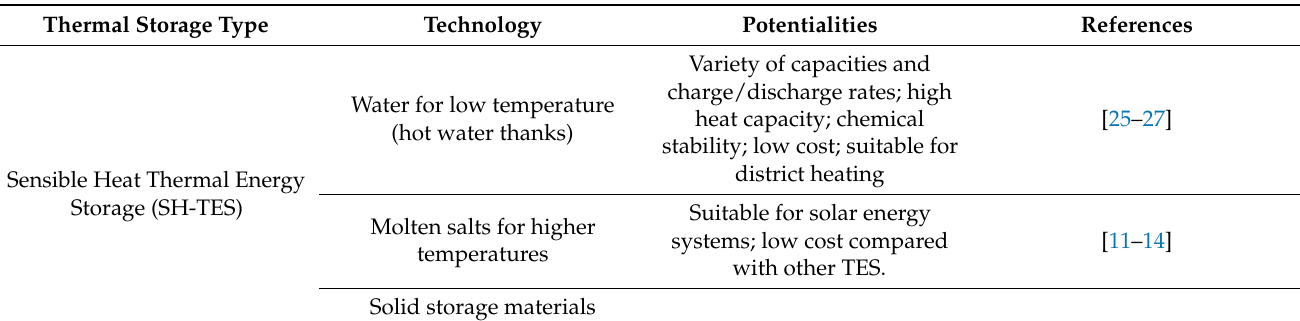
Table 1. Thermal energy storage typology and